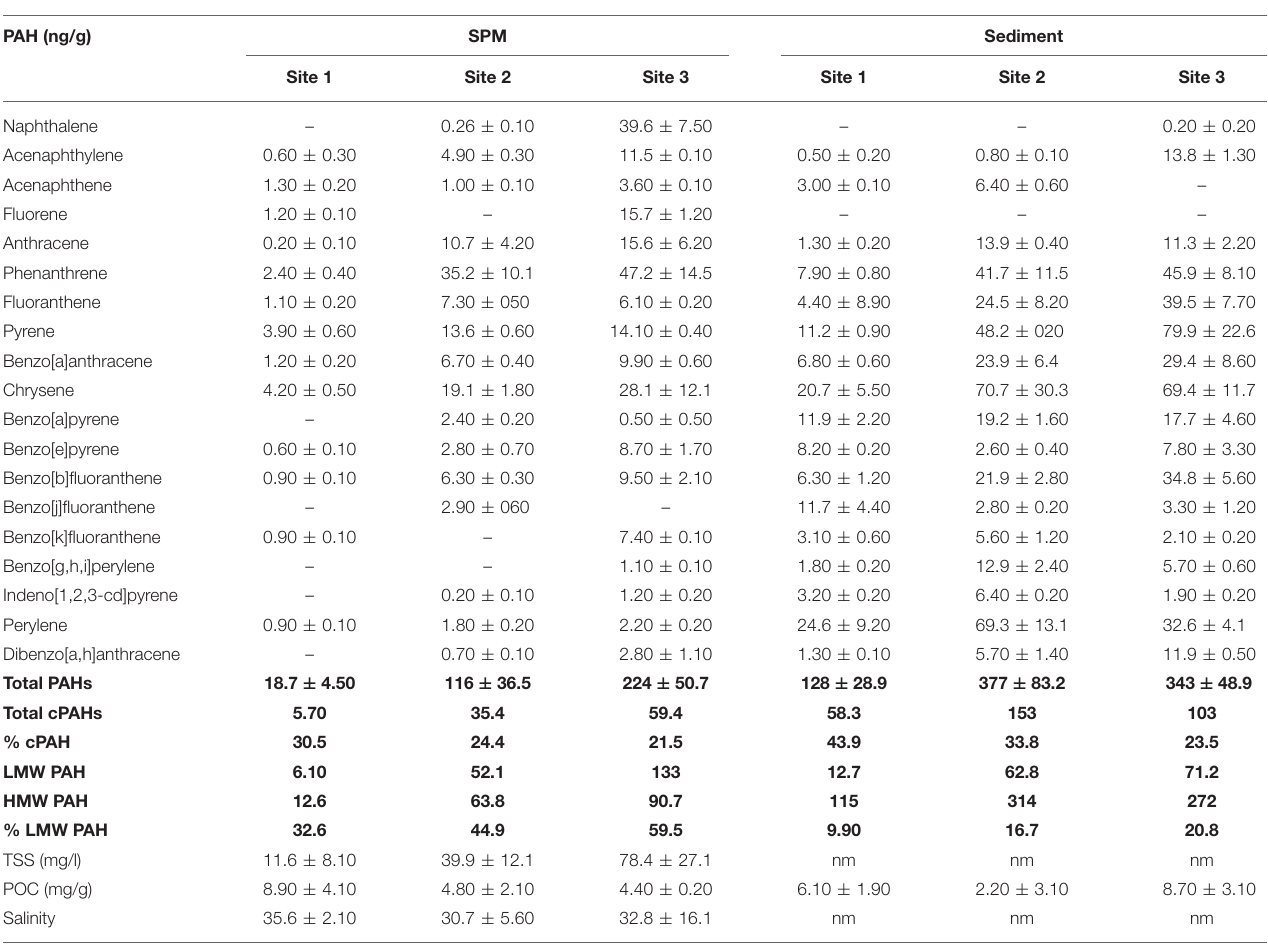
Values are expressed as mean ± SD of triplicates; – denotes PAHs not detected during the analyses; nm, not measured.